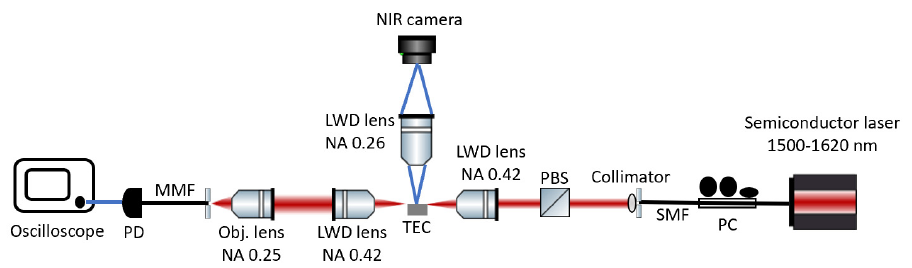
Figure 4. Schematic of the experimental setup.